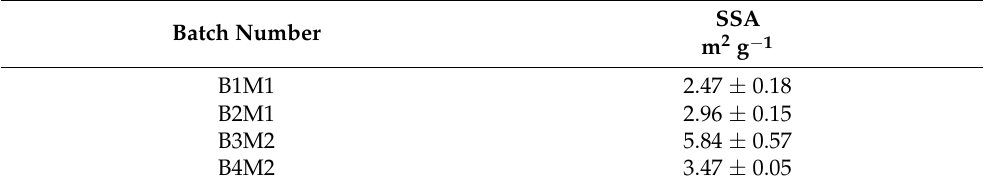
Table 4. Specific Surface Area (SSA) of the four α rifaximin samples. Mean value ± standard deviation (n =